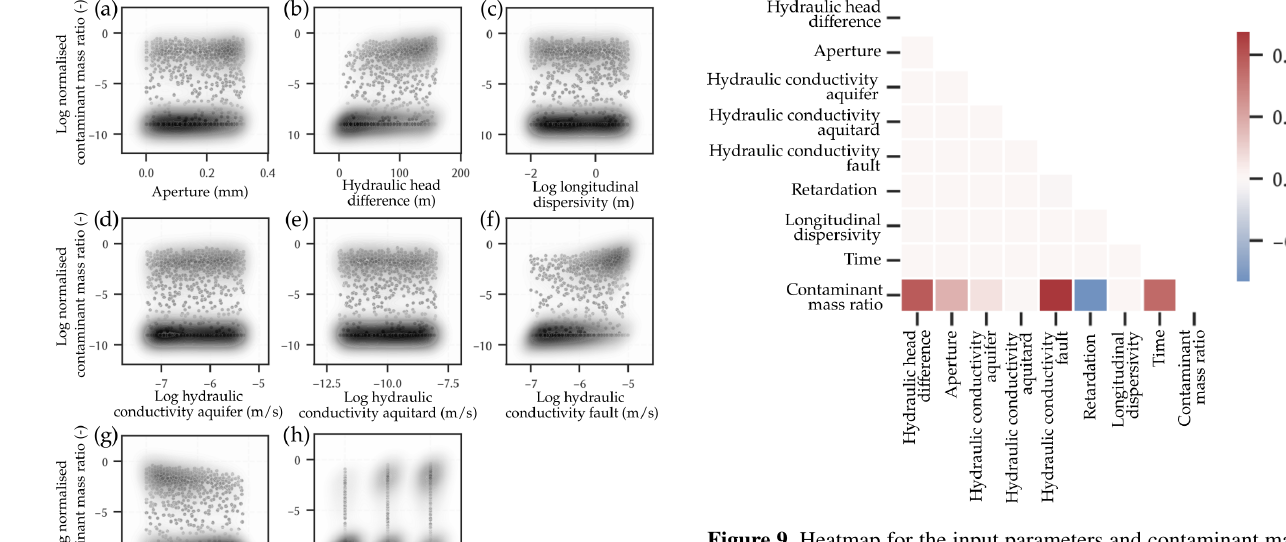
Figure 9. Heatmap for the input parameters and contaminant mass ratio in the fresh water aquifer showing Pearson’s correlation coef- ficients for each parameter